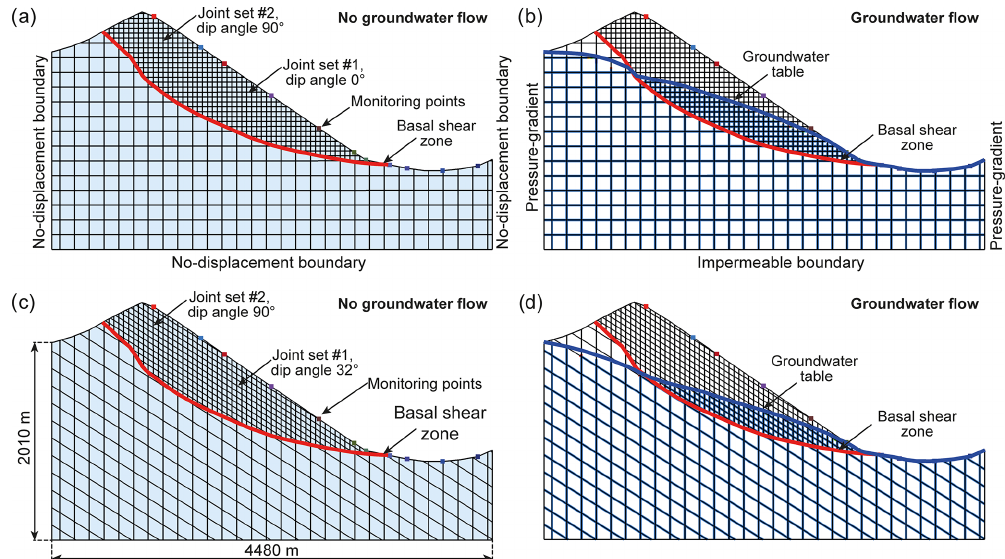
Figure 9. Model set-up and groundwater conditions of modelling scenario II: (a) model geometry characterized by a fully persistent hori- zontal (dip angle 90 ◦ ) and vertical (dip angle 0 ◦ ) joint set and the reconstructed basal shear zone (no groundwater flow), (b) same model geometry as in (a) but by considering groundwater flow, (c) model geometry characterized by a fully persistent inclined (dip angle 32 ◦ ) and vertical joint (dip angle 0 ◦ ) set and the reconstructed basal shear zone (no groundwater flow), and (d) same model geometry as in (c) but by considering groundwater flow. Monitoring points are included to prove if model runs have reached equilibrium (unbalanced forces) and stabilization (i.e. no ongoing